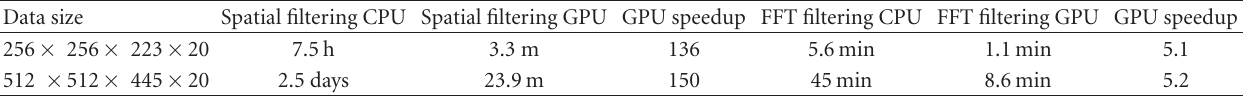
Table 5: Processing times for filtering with the 11 reconstruction filters of size 11 × 11 × 11 × 11 and calculating the denoised data for the di ff erent implementations. The processing times for the GPU do NOT include the time it takes to transfer the data to and from the GPU.